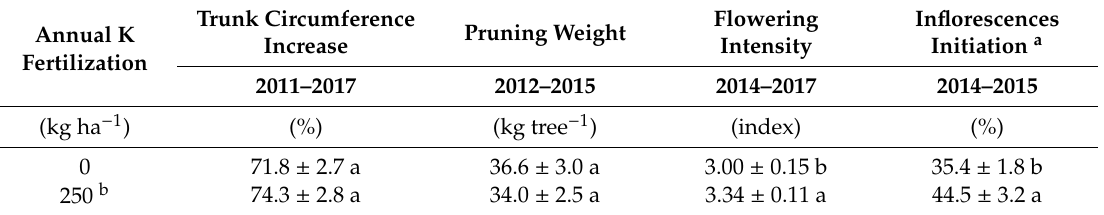
Table 1. Influence of K fertilization on vegetative and reproductive development.